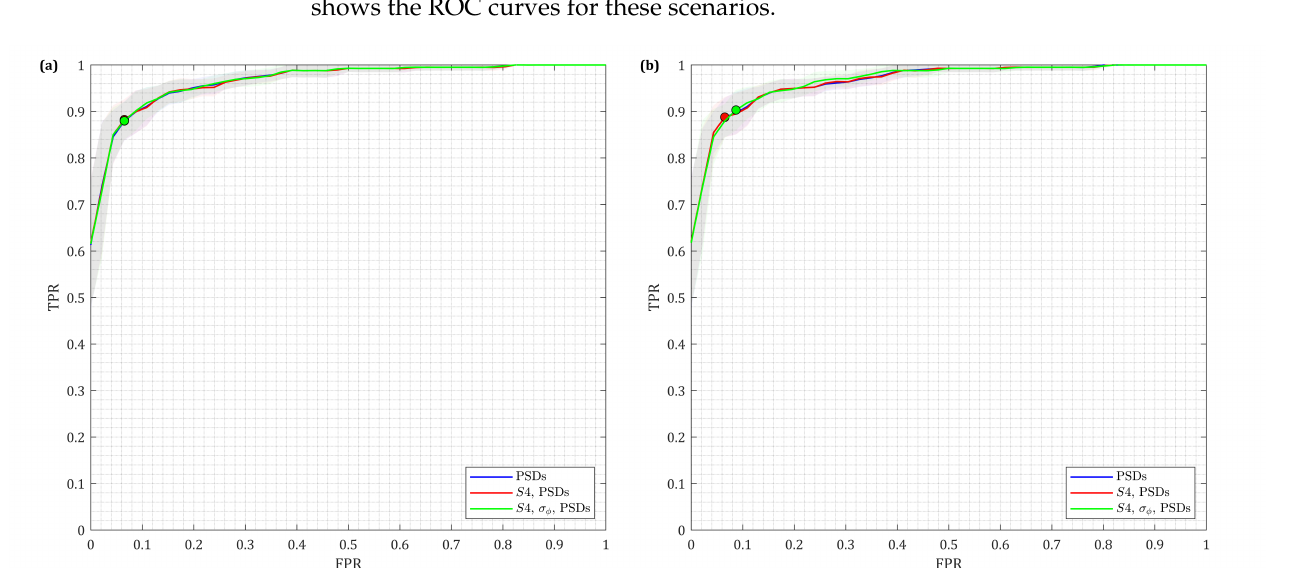
Figure 17. ROC curves for the combination of amplitude and phase training features obtained with ( a ) linear and ( b ) Gaus- sian kernel. Shaded regions correspond to the 95% confidence